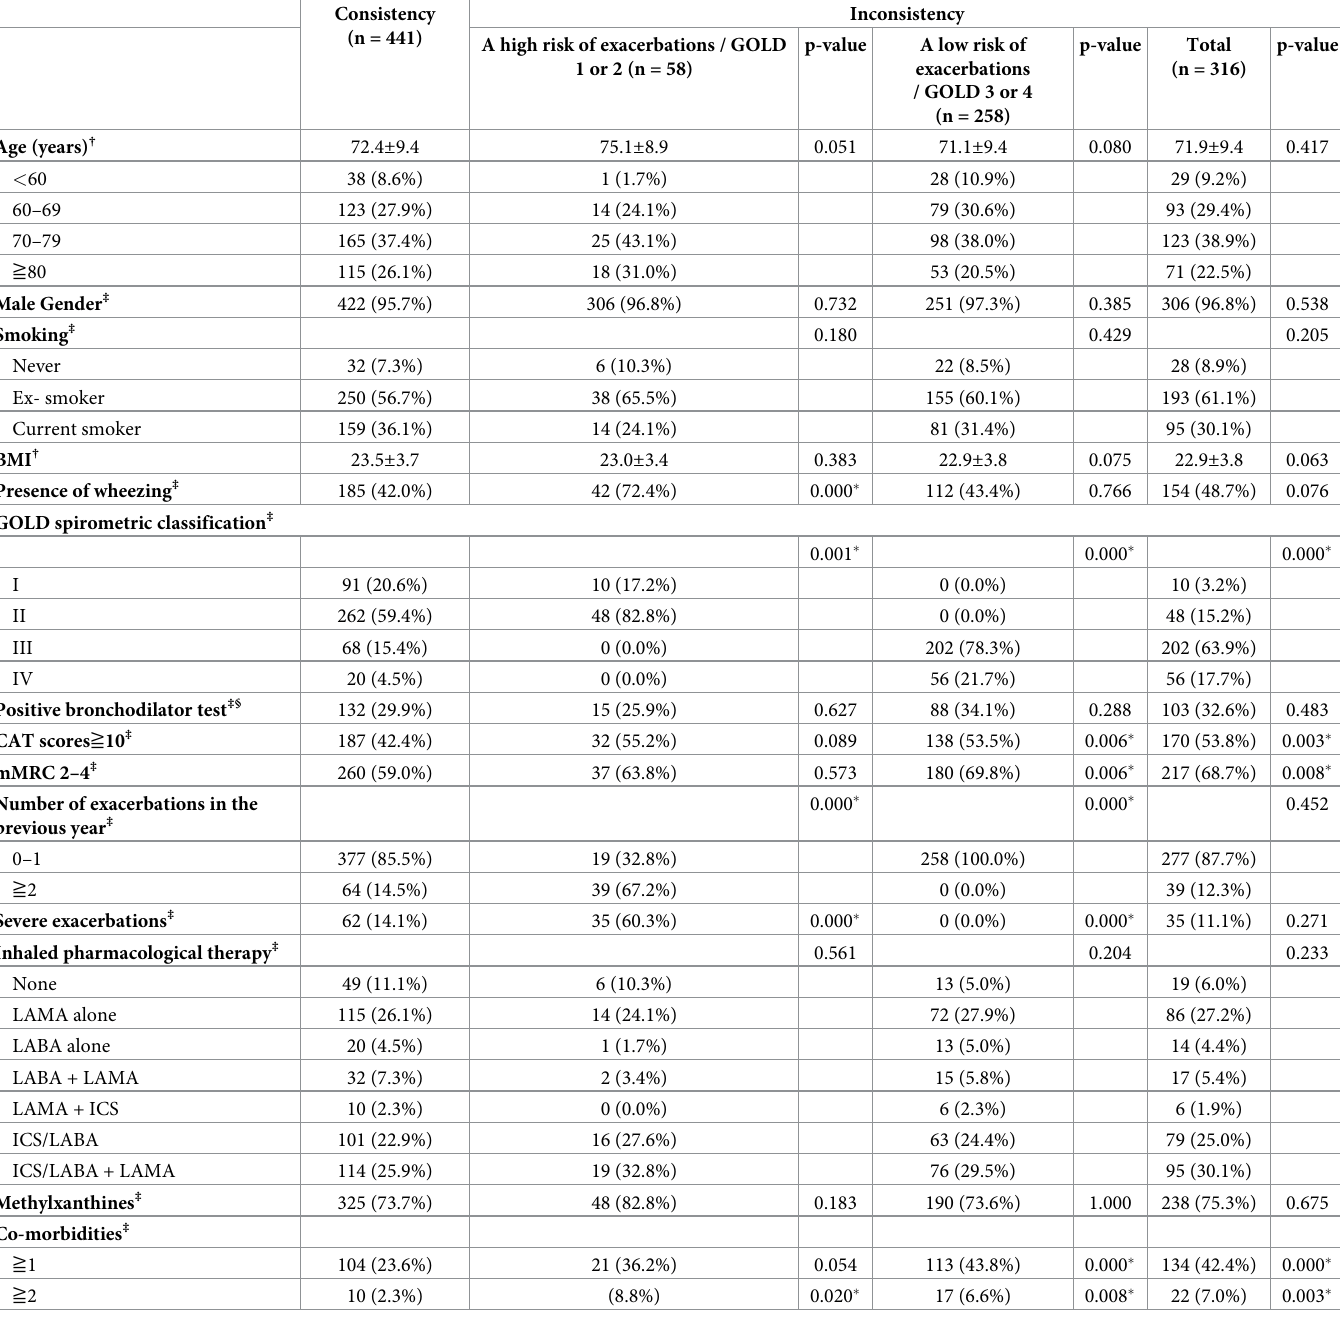
Table 2. Univariate analysis of the demographic characteristics and clinical data of the enrolled